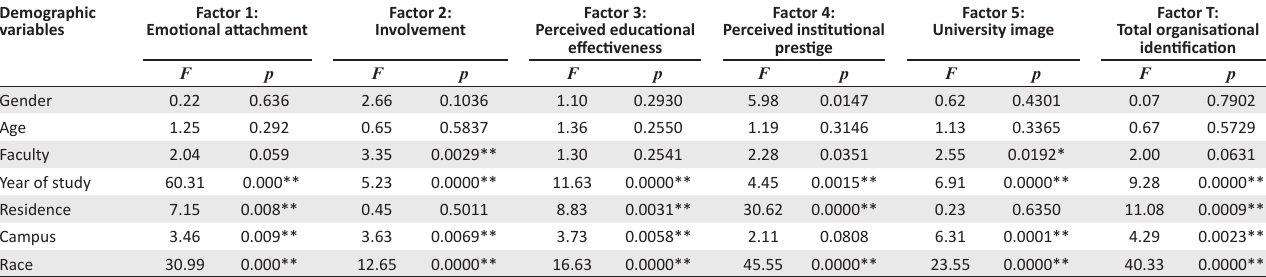
TABLE 4: The analysis of variance that determined the relationships between demographic variables and each of the factors. Demographic